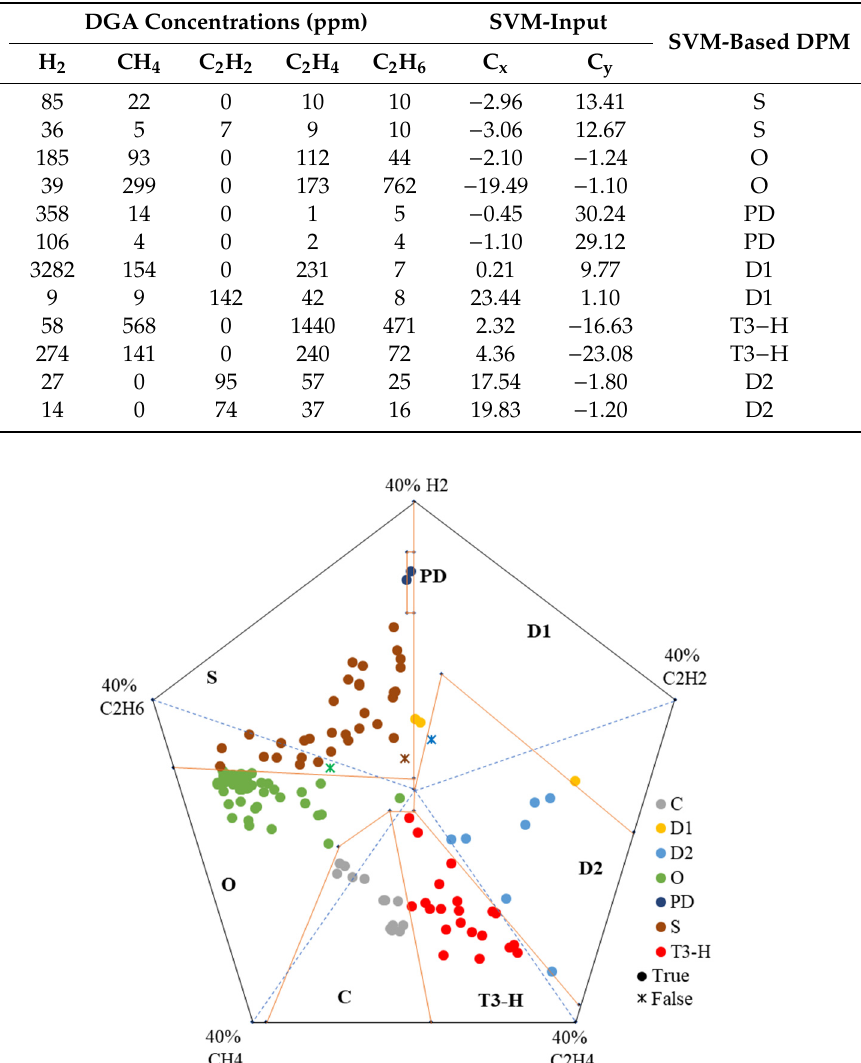
Figure 3. Confusion matrix of 961 data of SVM-based DPM. Table 9. 10 Samples of SVM-based DPM prediction. Table 9. 10 Samples of SVM-based DPM prediction.